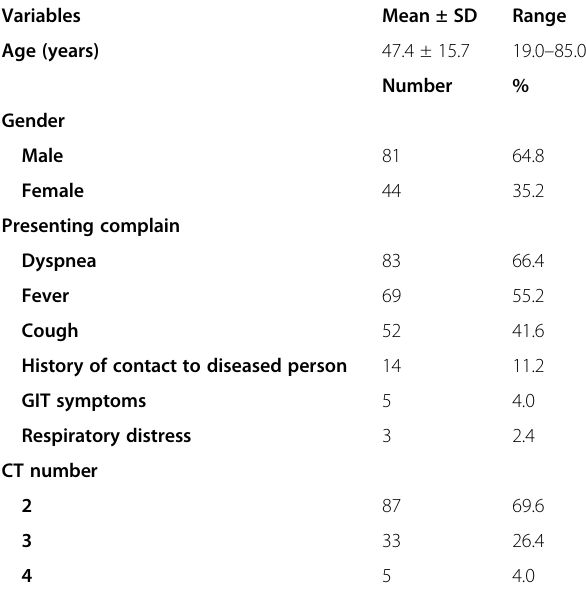
Table 1 Demographic data of the selected patients including age, sex, presenting complaint, and average CT studies